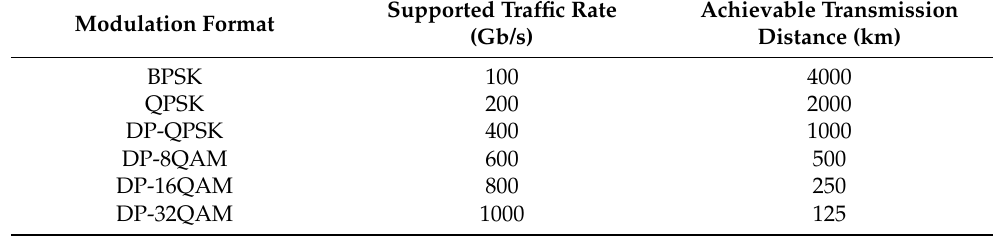
Table 2. Supported traffic rate and maximum transmission distance under different modulation formats using a 125 GHz spectrum block.